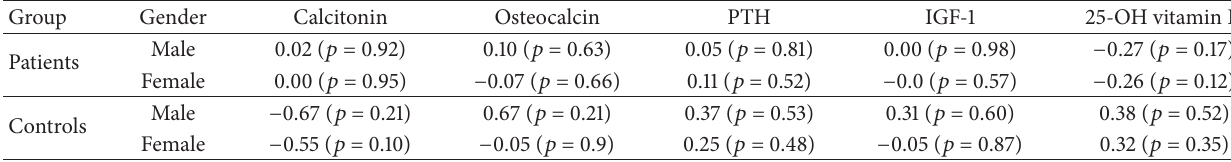
Table 5: Correlation between lean body mass and calcium hormones.